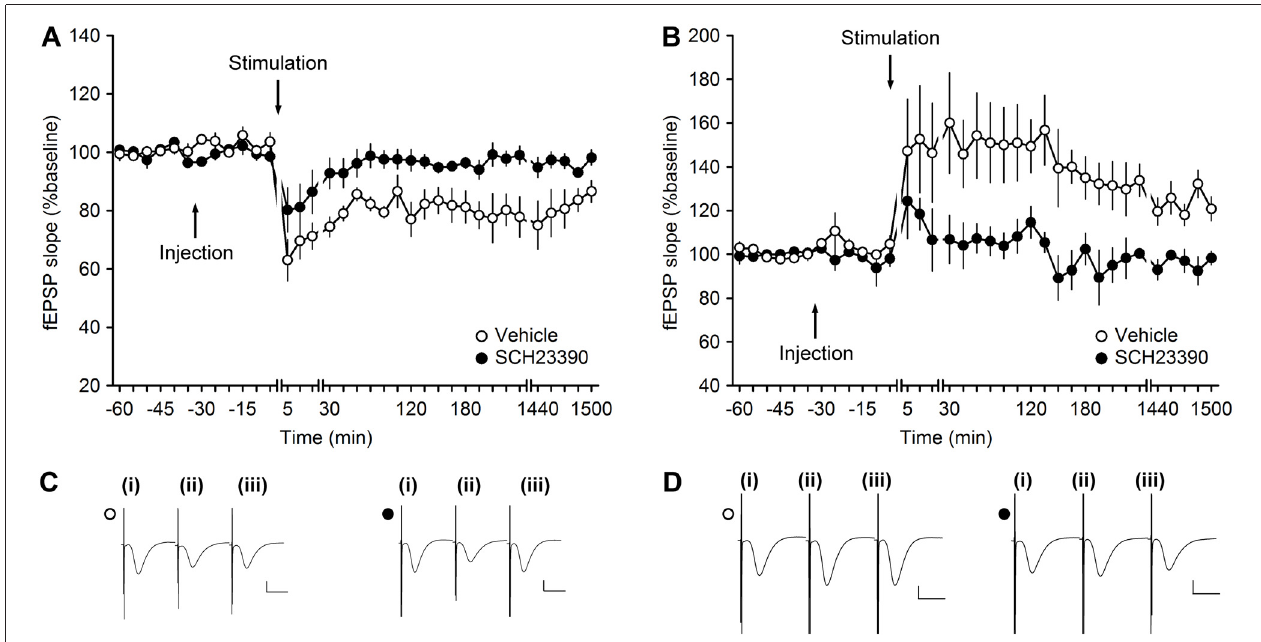
FIGURE 3 | Antagonism of D1/D5-receptors inhibits synaptic plasticity at MF-CA3 synapses. (A) LFS (1 Hz, 900 pulses) results in LTD in vehicle-treated animals. LFS in the presence of SCH23390 (30 µ g) significantly prevents LTD at MF-CA3 synapses. (B) HFS (four trains of 100 pulses at 100 Hz) elicits LTP at MF-CA3 synapses of vehicle-treated animals, whereas antagonism of D1/D5 receptors (SCH23390, 30 µ g) significantly prevents LTP. Line breaks indicate change in time scale. (C) Analog traces depict fEPSPs recorded at MF-CA3 synapses during an LTD experiment in control animals (open circle) and SCH23390-treated animals (filled circle); (i) pre-LFS; (ii) post-LFS; and (iii) 24 h post-LFS. Vertical scale bar: 1 mV, horizontal scale bar: 10 ms. (D) Analog traces depict fEPSPs recorded at MF-CA3 synapses during an LTP experiment; (i) pre-HFS; (ii) post-HFS; and (iii) 24 h post-HFS in the presence of vehicle (open circle) or SCH23390 (filled circle). Vertical scale bar: 1 mV, horizontal scale bar: 10